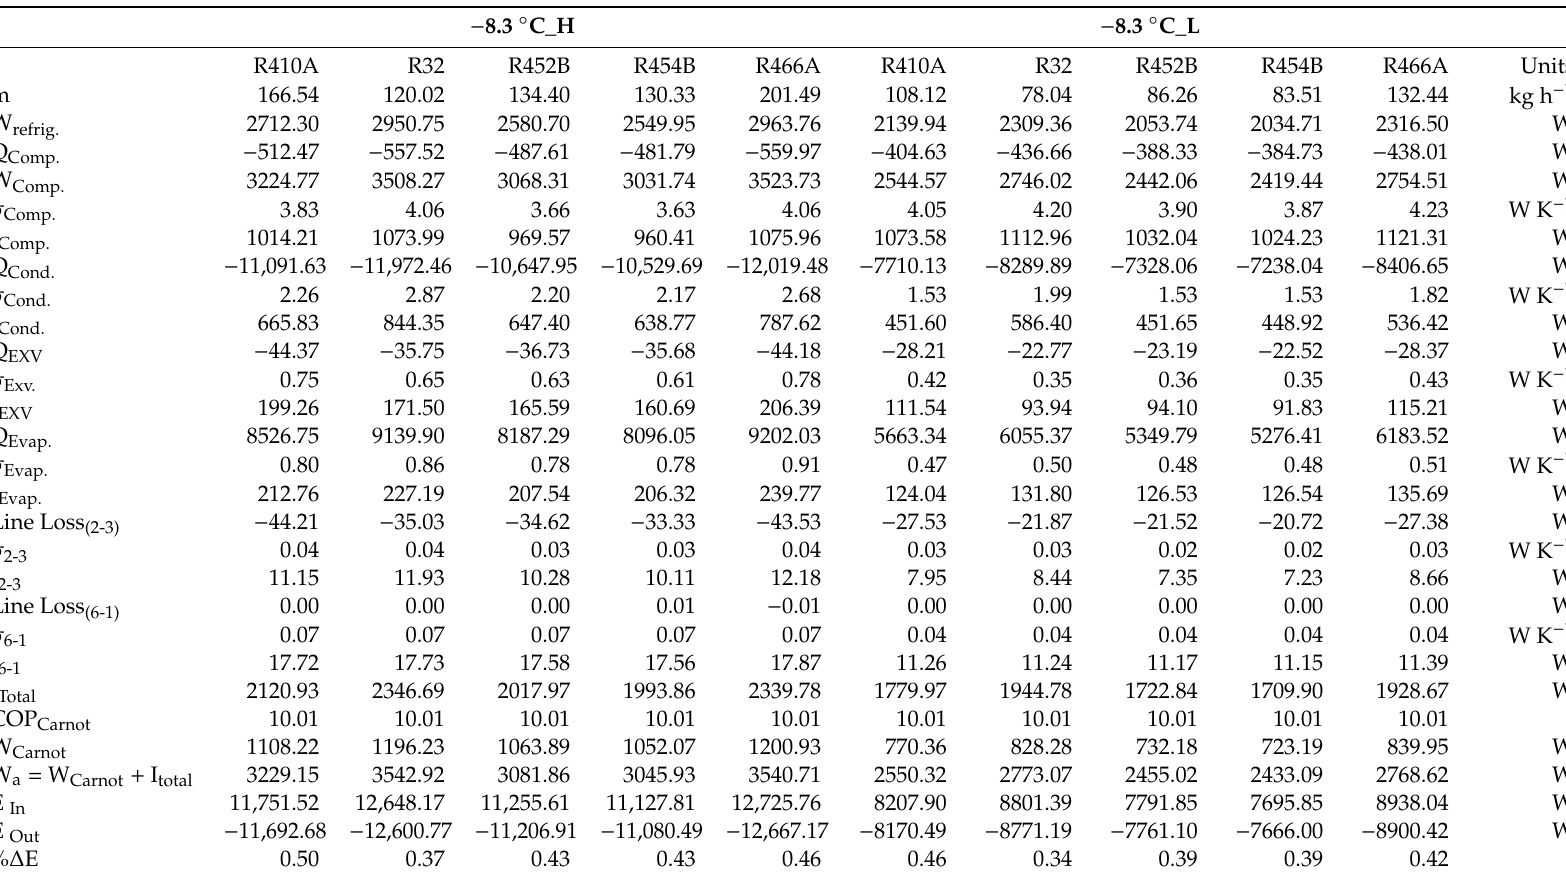
Table 7. Thermal and mechanical energy exchanges from the HPDM model and application of Equations (8)–(11), at − 8.3 ◦ C ambient